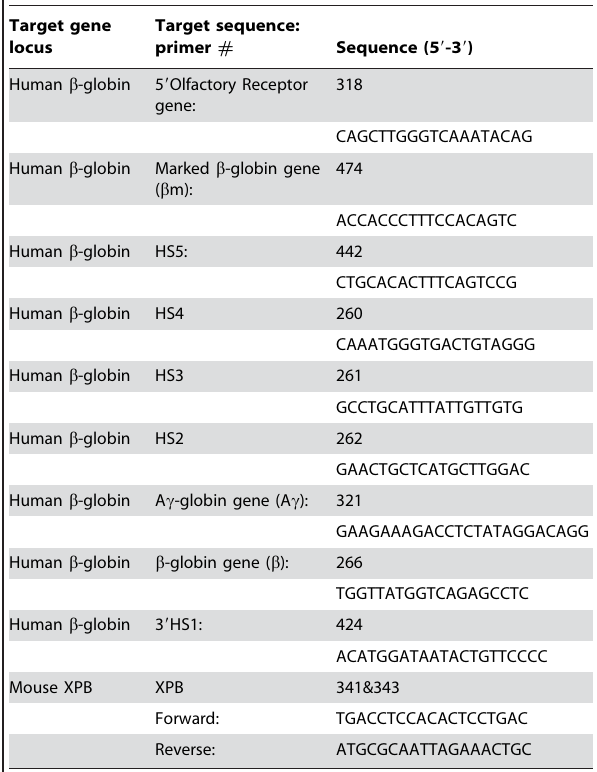
Table 1. Sequence of 3C-PCR primers. Table 2. PCR primers used in the Anti-CTCF ChIP Real-time PCR